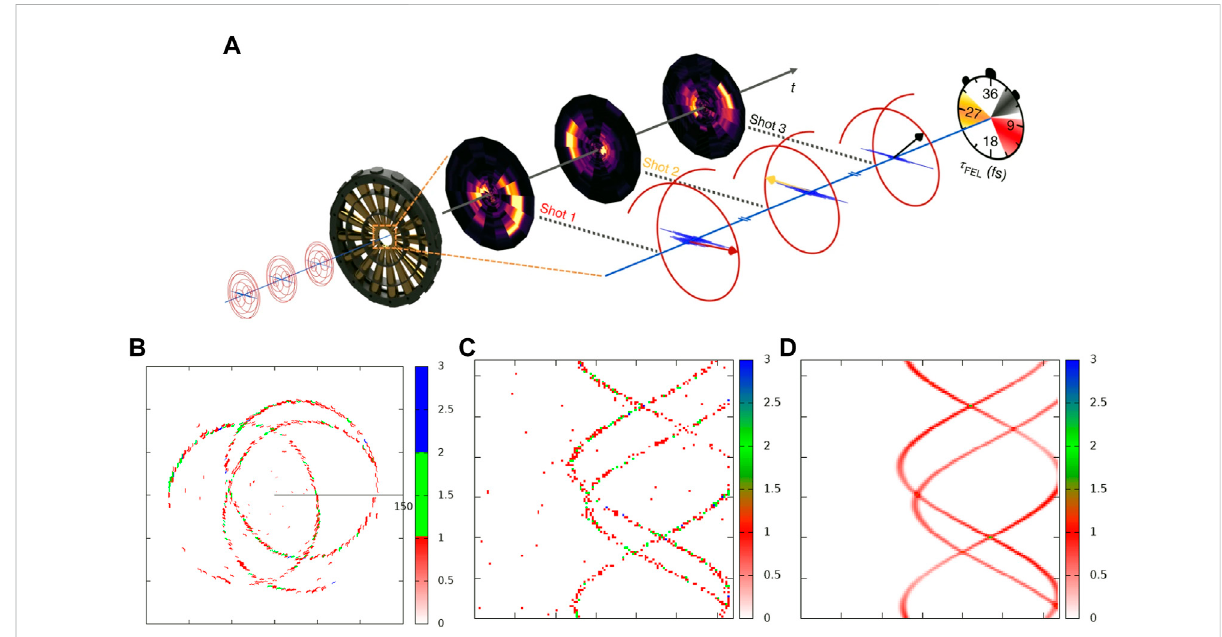
FIGURE 1 (A) Schematic of attosecond angular streaking reproduced from Ref. 9, one of the many use cases for angular array spectrometers for LCLS-II single-shot diagnostics. Sample image of angular streaking of SASE pulses in polar (B) and Cartesian (C) representations. Panel (D) shows the emission probability that is our desired output of the inference